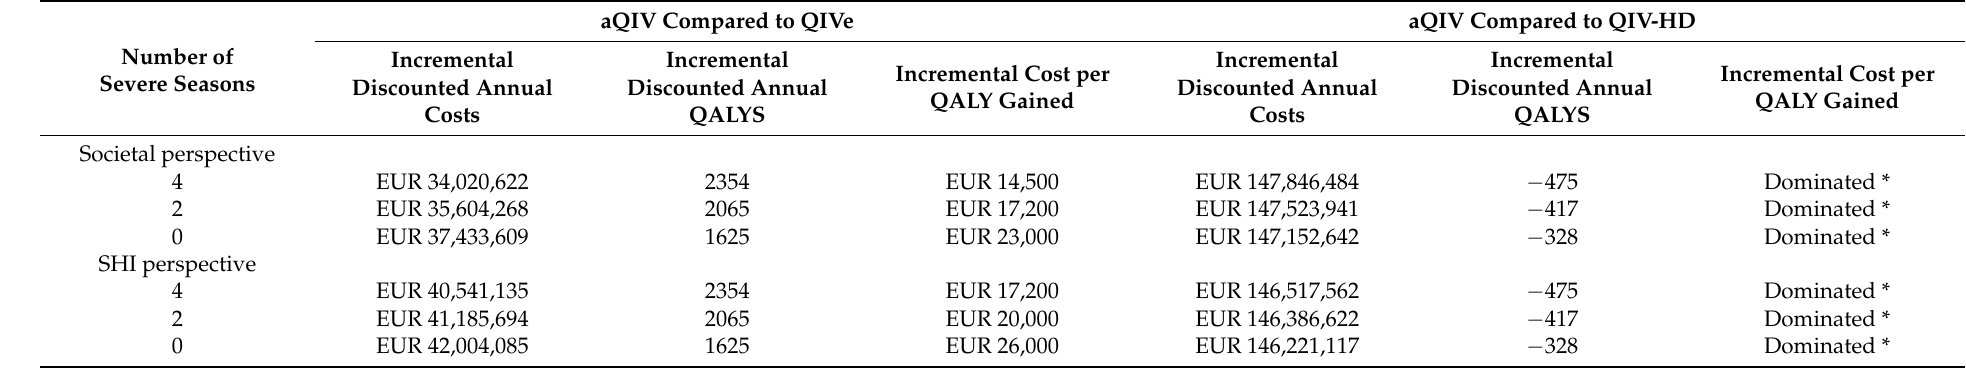
Table 5. The cost effectiveness of aQIV compared to QIVe and QIV-HD compared to aQIV by perspective and number of severe